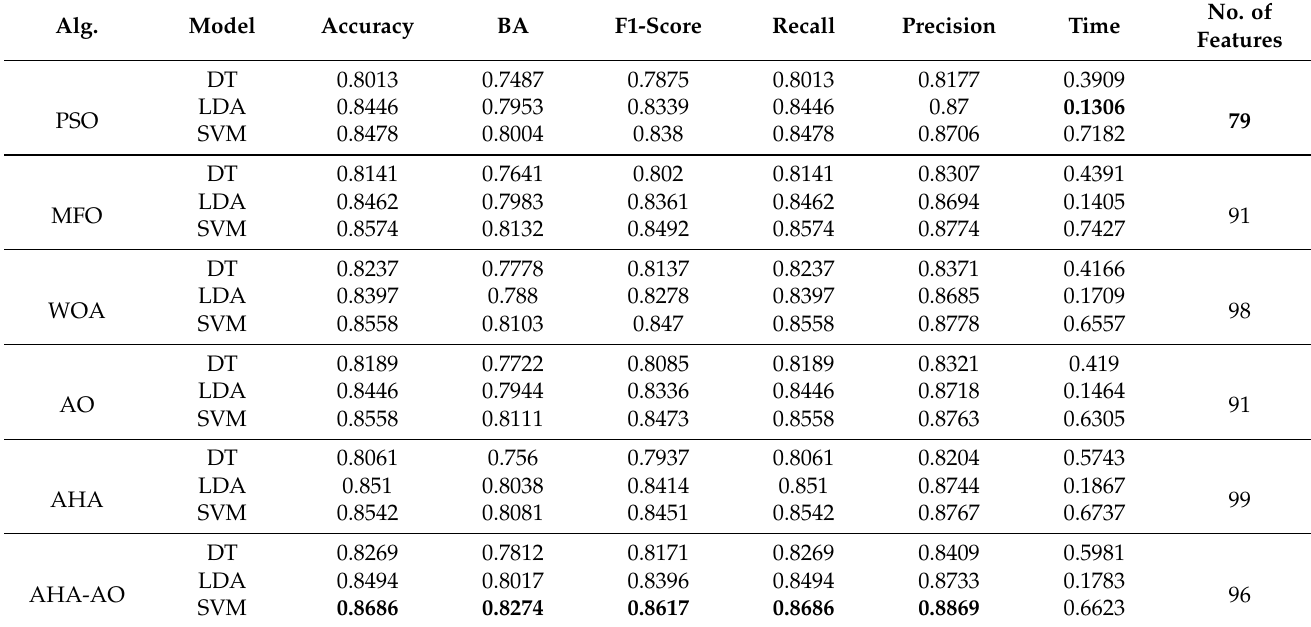
Table 6. Classification results of each feature selection optimization algorithm on the Chest- XRay dataset (bold refers to best